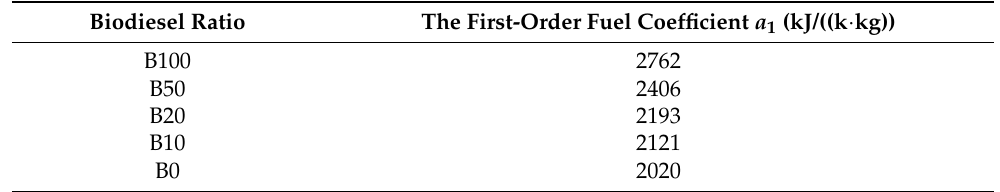
Table 1. Coefficient ( a 1 ) of different ratios biodiesel.